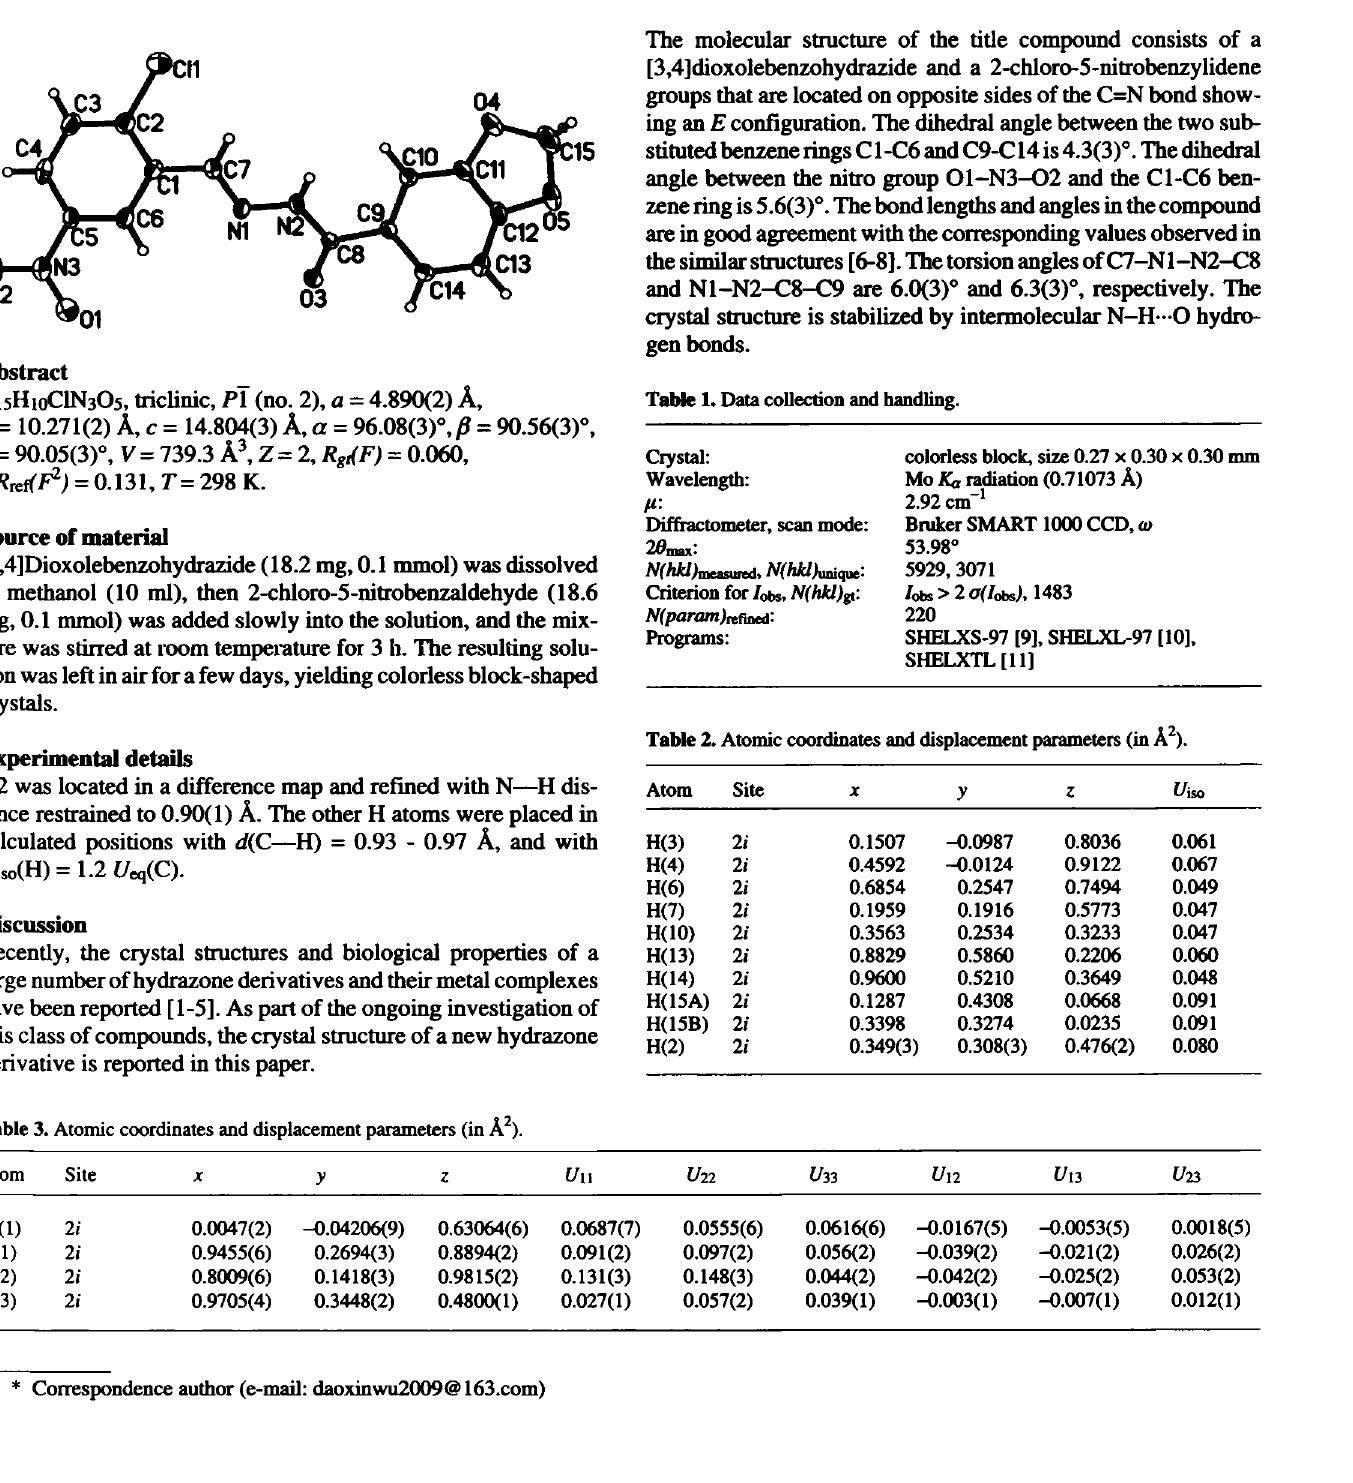
Table 2. Atomic coordinates and displacement parameters (in Â 2 ).